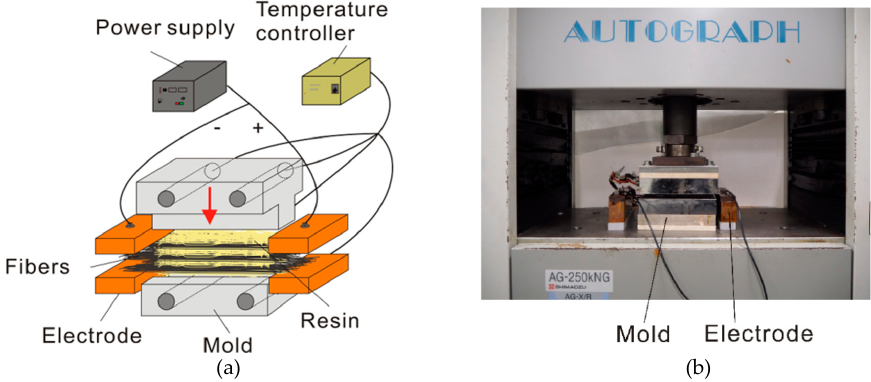
Figure 3. Schematic drawing and photo image of carbon fiber reinforced thermoplastics (CFRTP) hot press molding using direct resistance heating to carbon fiber. ( a ) Schematic drawing. ( b ) Photo image.